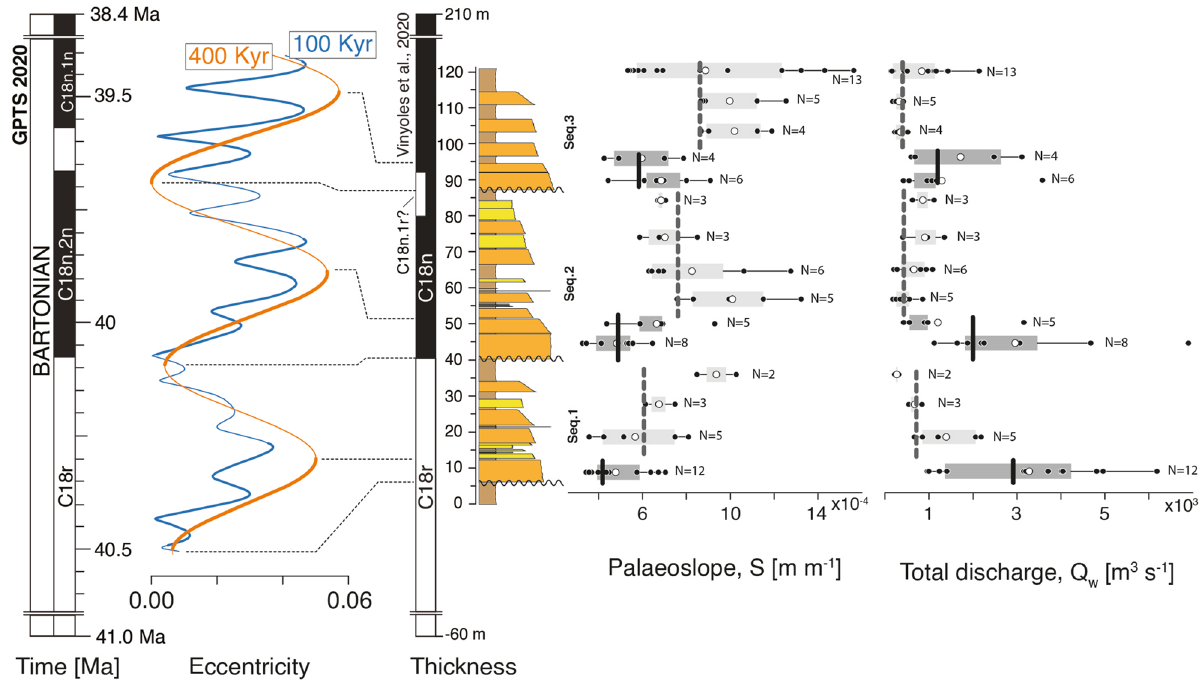
Figure 8. Eccentricity modulated water discharge variations in the Escanilla Formation. A plausible relationship between eccentricity cycles and water discharge variations which in turn control changes in stratigraphic architecture from HA to LA intervals such that palaeoslopes are lower in HA intervals and are higher in LA